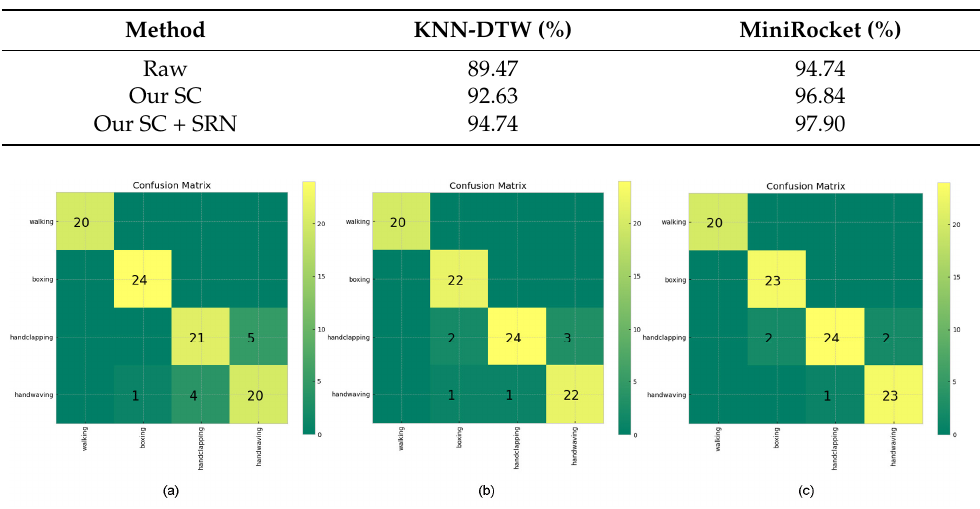
Table 8. Classification accuracy for different methods and networks with KTH-4.